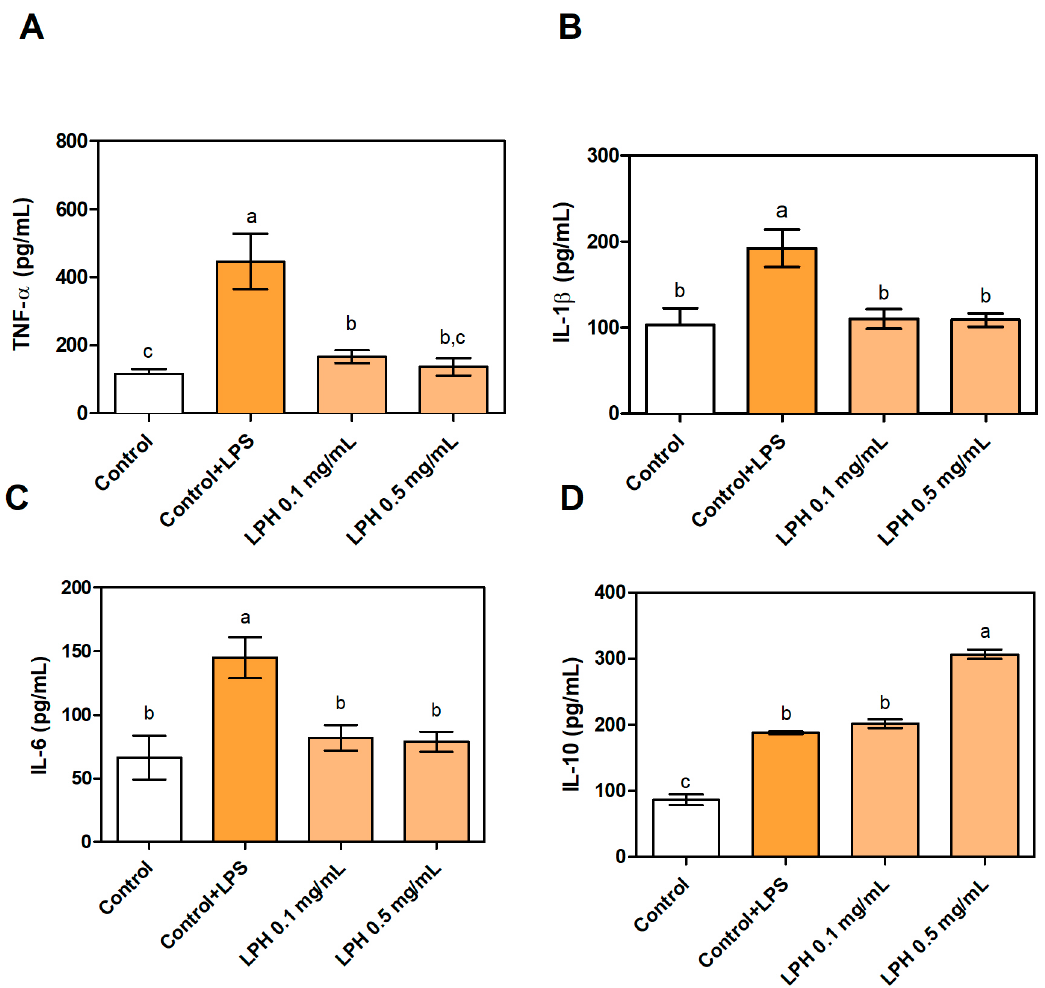
Figure 4. Production of ( A ) TNF- α , ( B ) IL-1 β , ( C ) IL-6, and ( D ) IL-10 by THP-1-derived macrophages (Control), LPS-stimulated THP-1-derived macrophages (Control+LPS), and Control+LPS treated with 0.1 (LPH 0.1) and 0.5 mg/mL (LPH 0.5) of LPH. In all cases, THP-1 cells were co-cultured with Caco-2 cells in Millicell® systems. Values marked with different letters are significantly different ( p < 0.05).